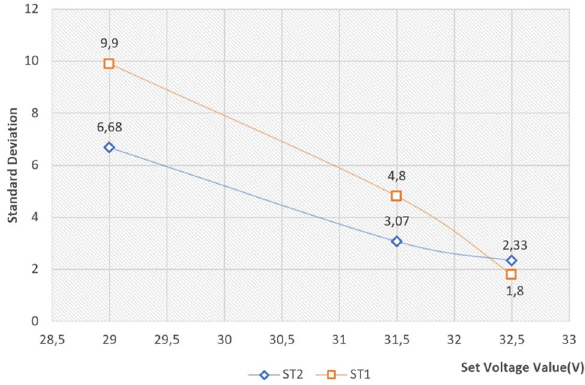
Fig. 17 Stability score calculation results for ST1 and